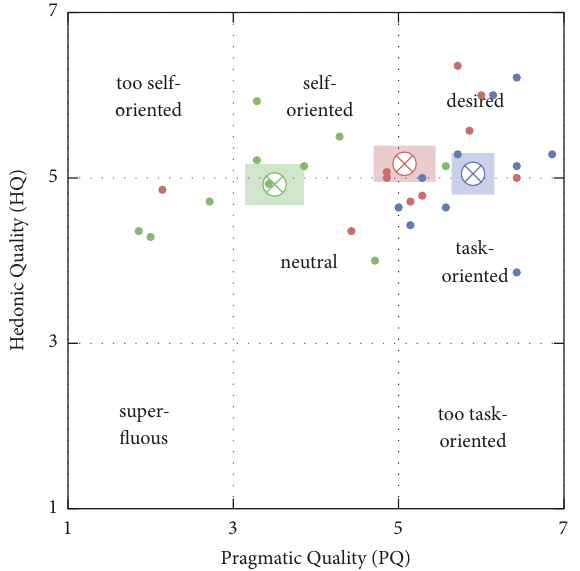
Figure 13: AttrakDiff-2 portfolio representation, according to [86], depicting results from the evaluation of the semi-manual segmentation prototype (blue), guided prototype (green), and joint prototype (red). The rectangular areas illustrate the 95 % confidence intervals for the mean value in each dimension. The mean intervals are 5.5 % for PQ and 4.0 % for